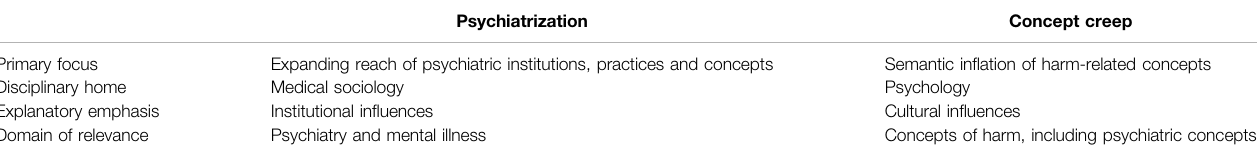
TABLE 1 | Selected contrasts been the concepts of psychiatrization and concept